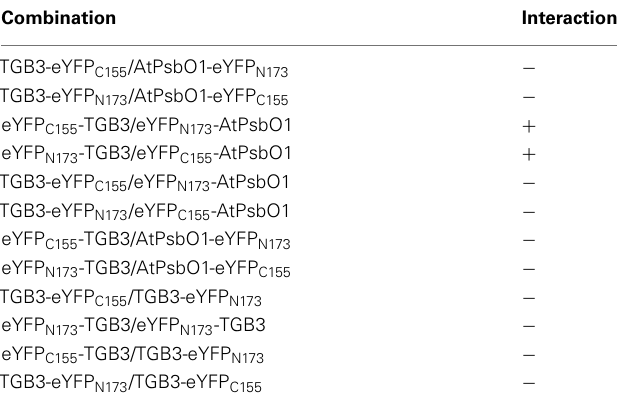
Table 2 | Interactions ofAltMVTGB3 andAtPsbO1 as detected by